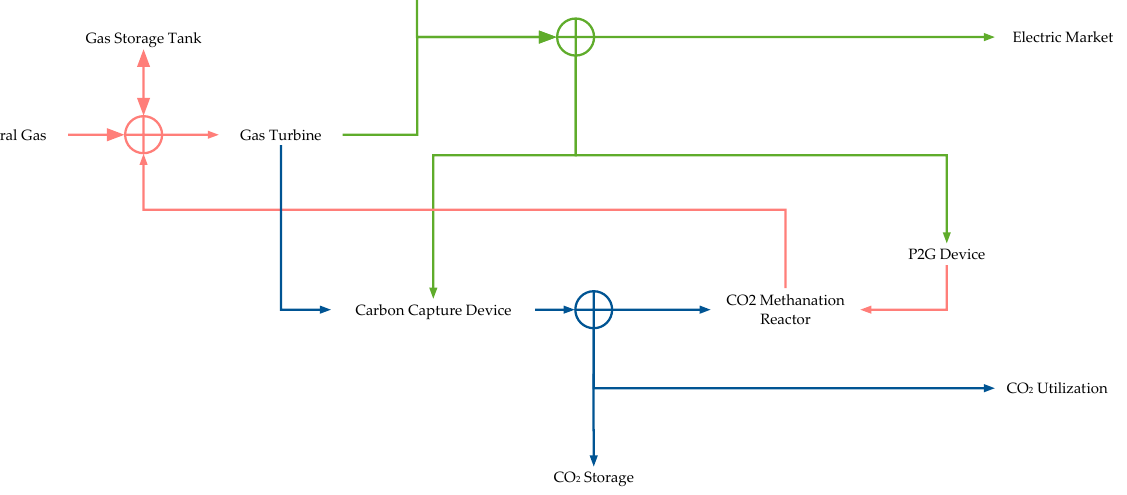
Figure 1. The main system configuration of an NZCEP plant. Natural gas energy is represented by the orange line, carbon flow by the blue line and electrical energy by the green line.